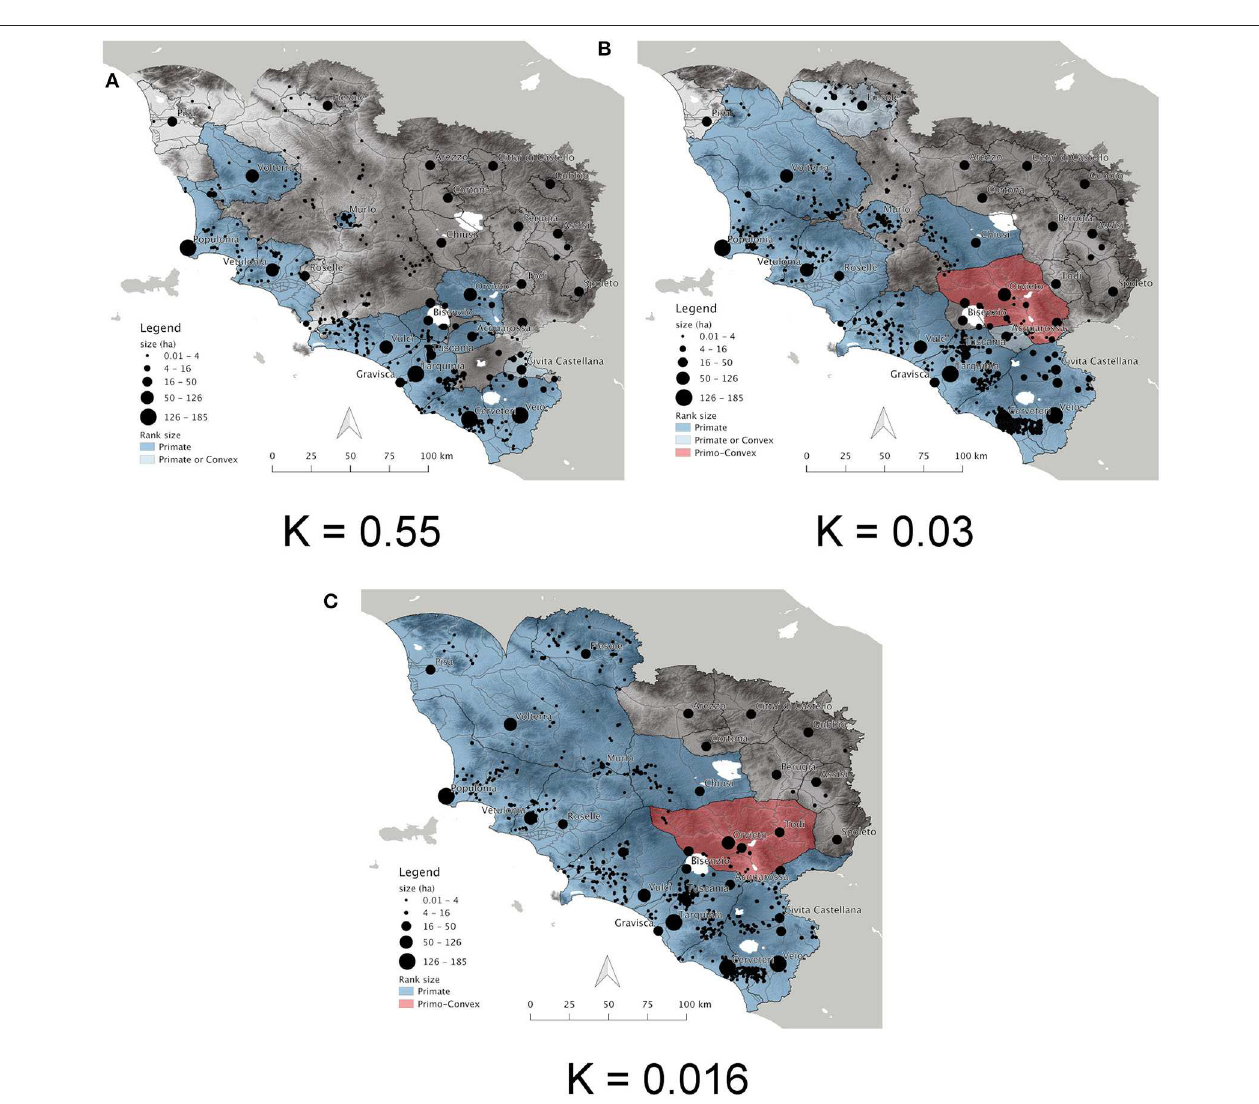
FIGURE 2 | The open access rural data inserted into the territorial landscape defined by XTENT. (A) Iron Age/Orientalizing data. (B) Archaic data. (C) Post-Archaic